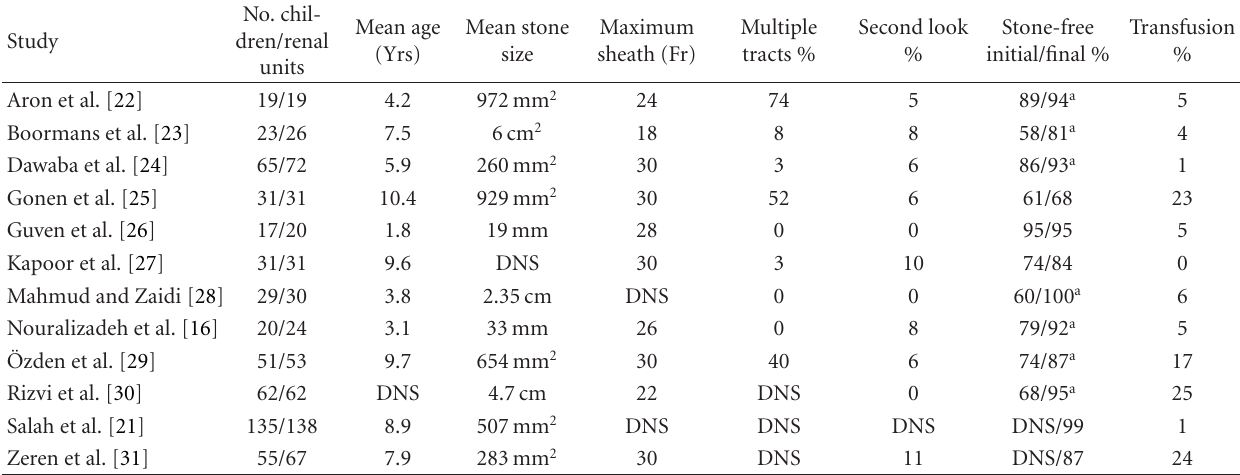
Table 2: Comparison of pediatric percutaneous nephrolithotomy series DNS: did not specify; a includes SWL therapy.